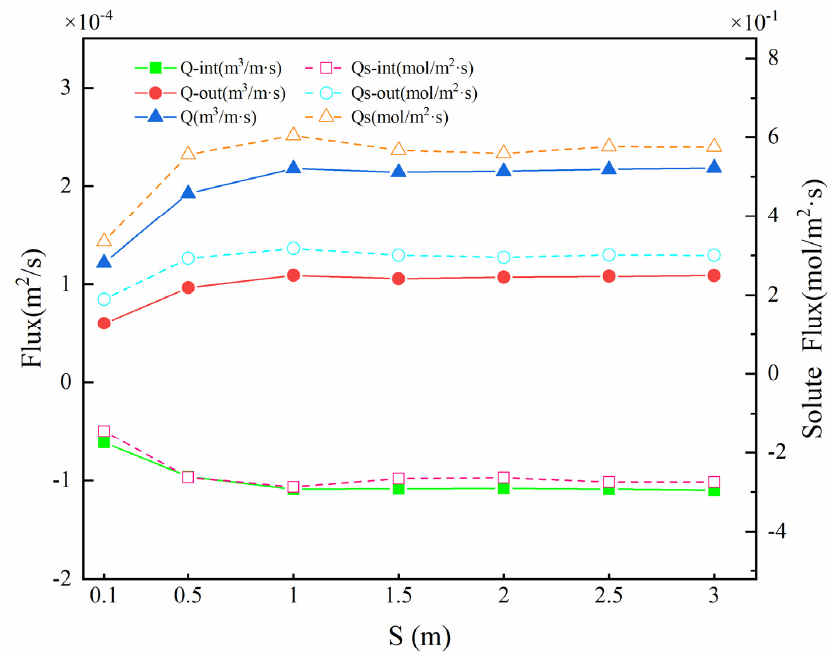
Figure 9. Vertical hyporheic exchange flux (Q), downwelling hyporheic flux (Q int ), upwelling hyporheic flux (Q out ), solute flux (Qs), downwelling solute flux (Q s-int ), and upwelling solute flux (Q s-out ) under different S values. The solid lines represent the hyporheic exchange flux; the dashed lines show the solute flux.